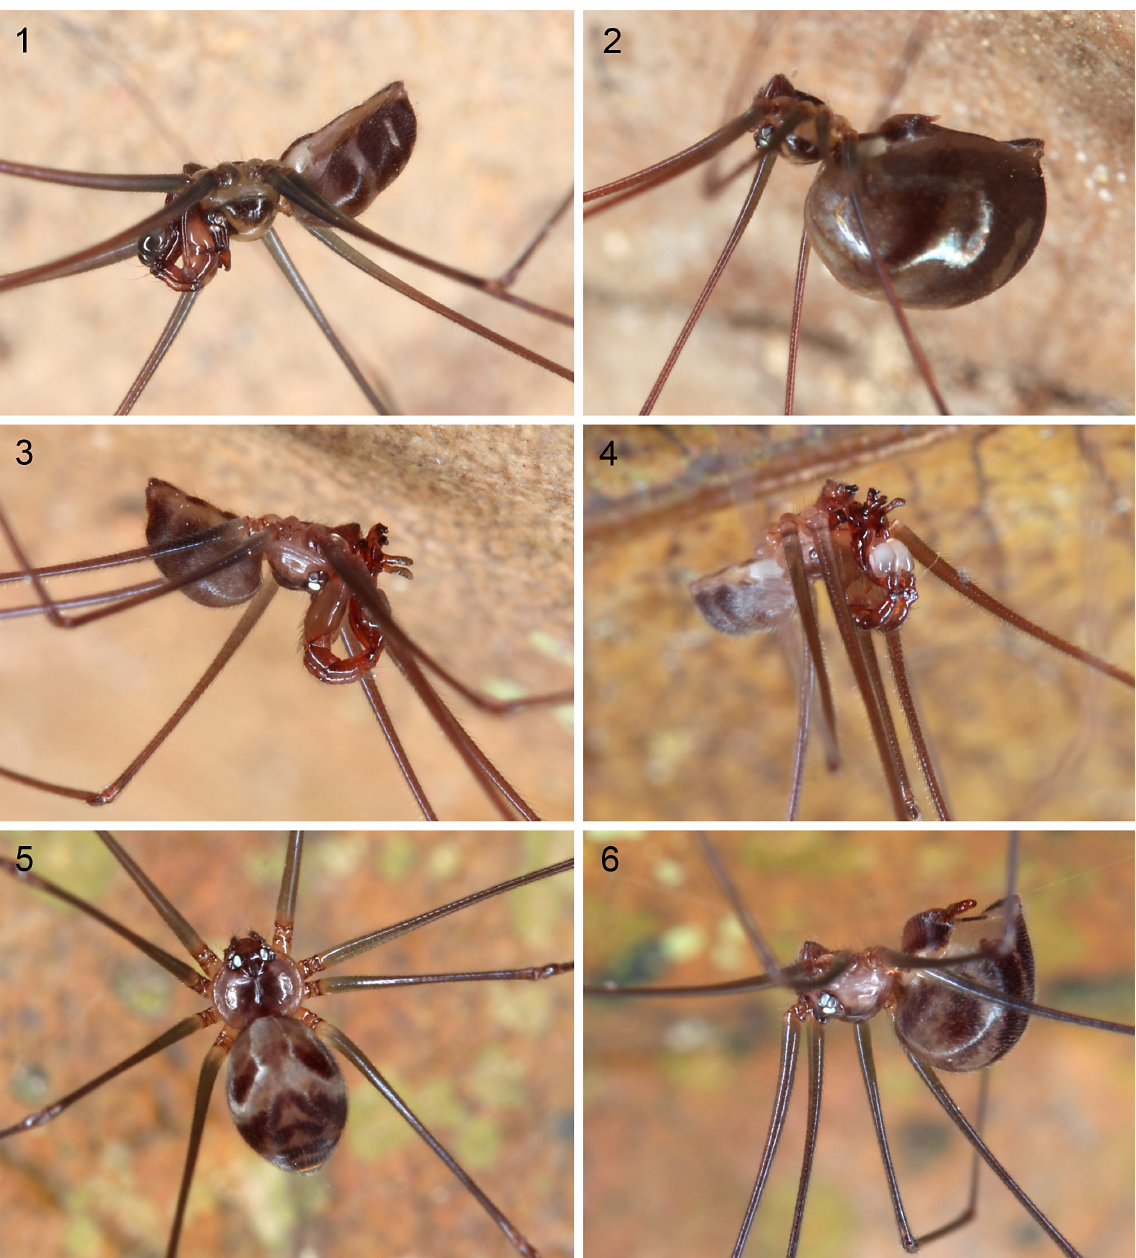
Figs 1–6. Live specimens. 1–2 . Hantu kapit gen. et sp. nov., ♂ and ♀ from Kapit, Sarawak. 3–6 .